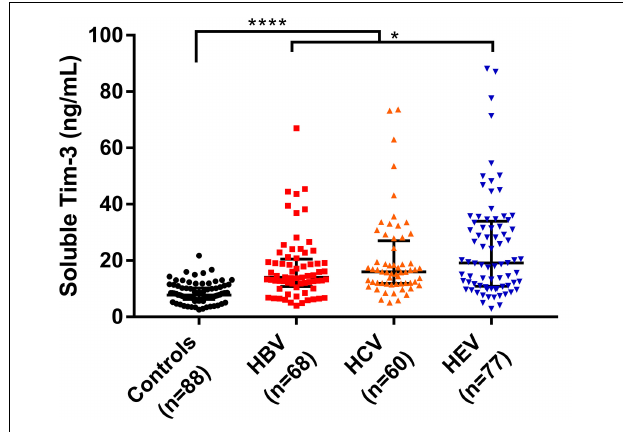
FIGURE 1 | sTim-3 content in uninfected v/s in patients infected with HBV, HCV, and HEV. * P < 0.05; **** P <